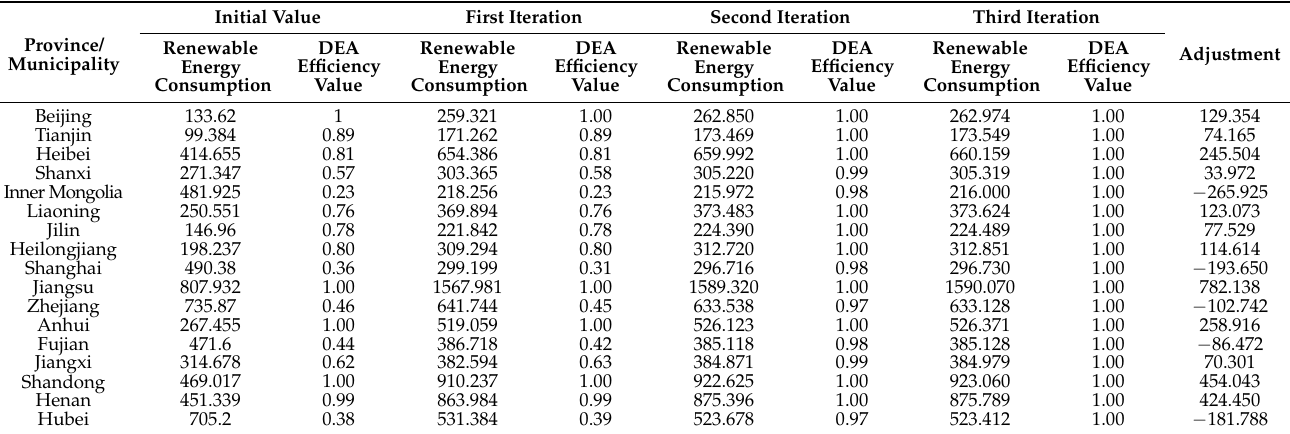
Table 5. RPS Allocation Efficiency and Adjustment Results for the